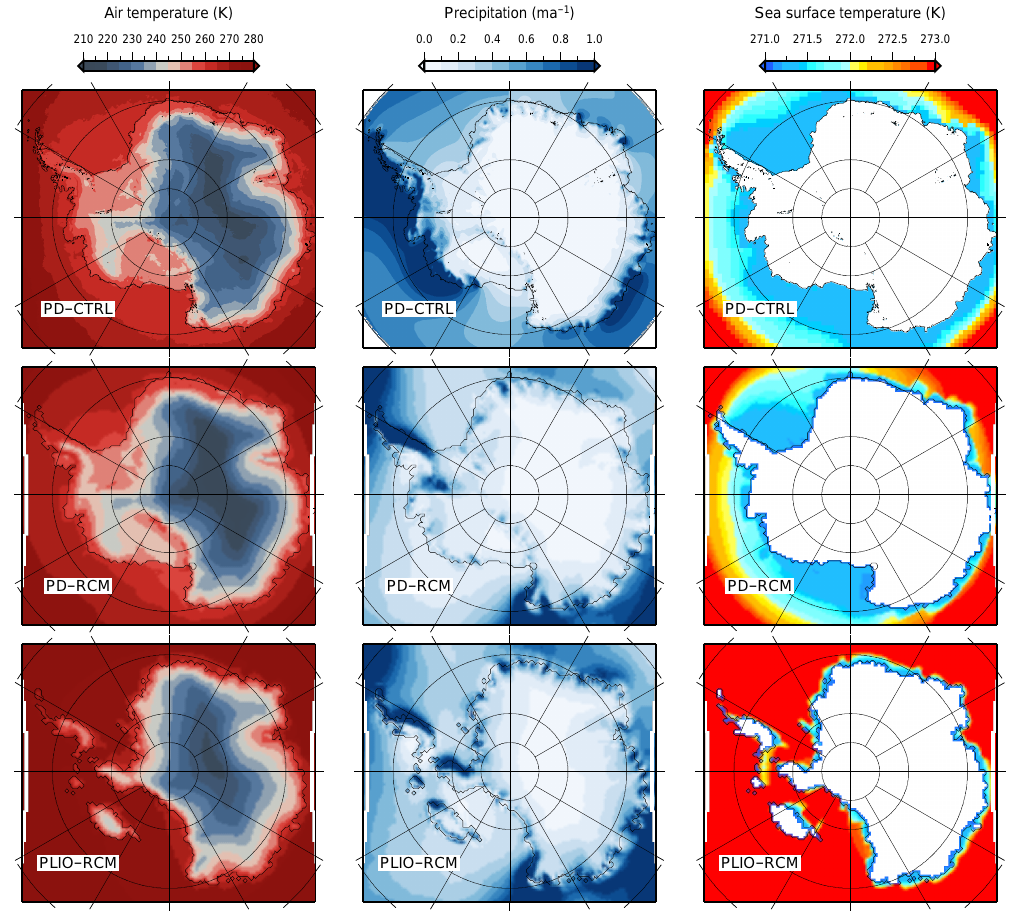
Figure 2. Air temperature, precipitation, and sea surface temperature used for our simulations. Top row: the “control” (CTRL) scenario, employing gridded data from observations and modelling of present-day conditions (Comiso, 2000; Lenaerts et al., 2012; Thompson and Pollard, 1997; Pal et al., 2007). Middle row: present-day conditions as simulated by the RCM. Bottom row: Pliocene conditions at 4.23Ma as simulated by the